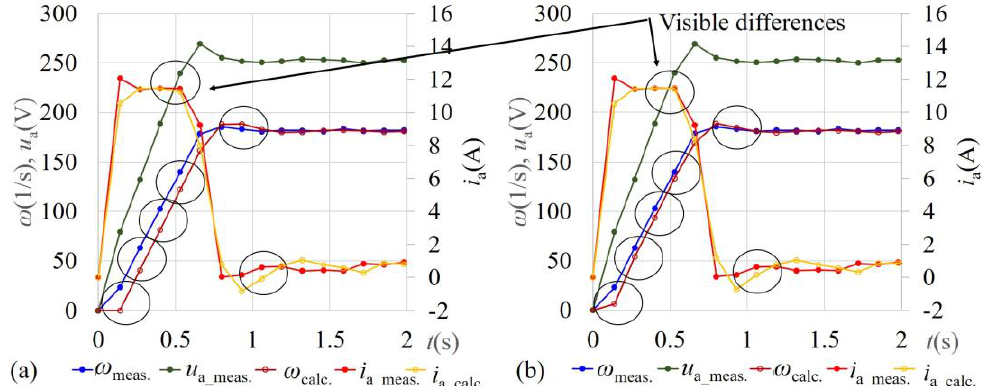
Figure 9. Measured and calculated responses in the case of MD2 using: ( a ) EM; ( b ) RK.